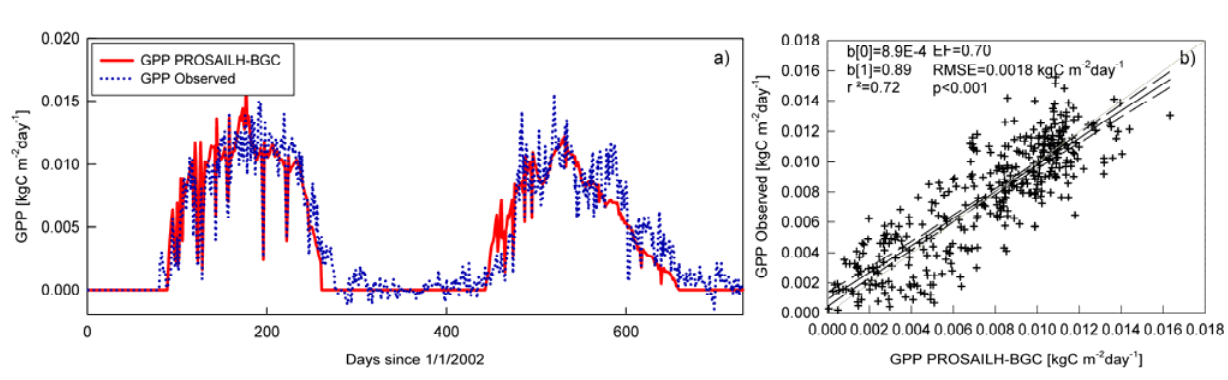
Figure 6 . a) Time courses of modeled (red straight line) and observed (blue dotted line) GPP for 2002 and 2003. b) Scatterplot of observed and modeled GPP, data from both the growing seasons were plotted with exclusion of data of the dormant period. The black straight line is the regression line, the dashed lines represent the 95 confidence intervals, the grey line is the 1:1 line. b[0] is the intercept, b[1] is the slope and p is the significance of the linear regression analysis observed vs